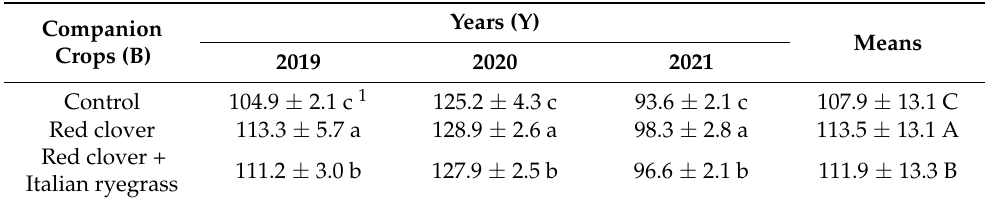
Table 2. Total protein content in spring barley grain according to companion crops in 2019–2021, g · kg − 1 d.m.